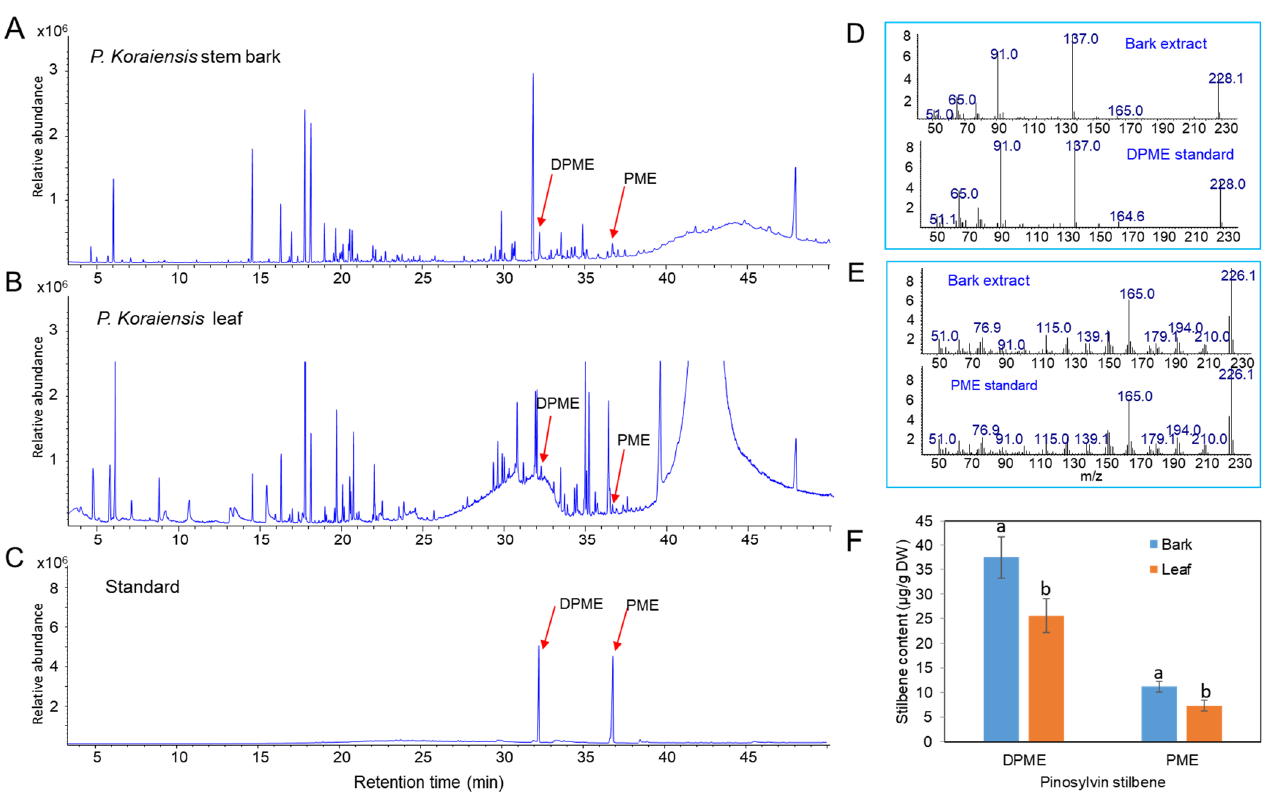
Figure 1. Analysis of DPME and PME in extracts of stem barks and needles of P. koraiensis plants by GC–MS analysis. ( A ) GC chromatogram of stem bark extracts. ( B ) GC chromatogram of needle extracts. ( C ) GC chromatogram of DPME and PME standards. ( D ) Mass fractions of the DPME peak (32.2 min) detected in stem bark extracts and DPME standards. ( E ) Mass fractions of the PME peak (36.6 min) detected in needle extracts and DPME standards. ( F ) Content of DPME and PME in stem barks and needles of P. koraiensis plants. Different letters above the bars indicate significantly different values ( p < 0.05), calculated using one-way ANOVA followed by Duncan's post hoc analysis .